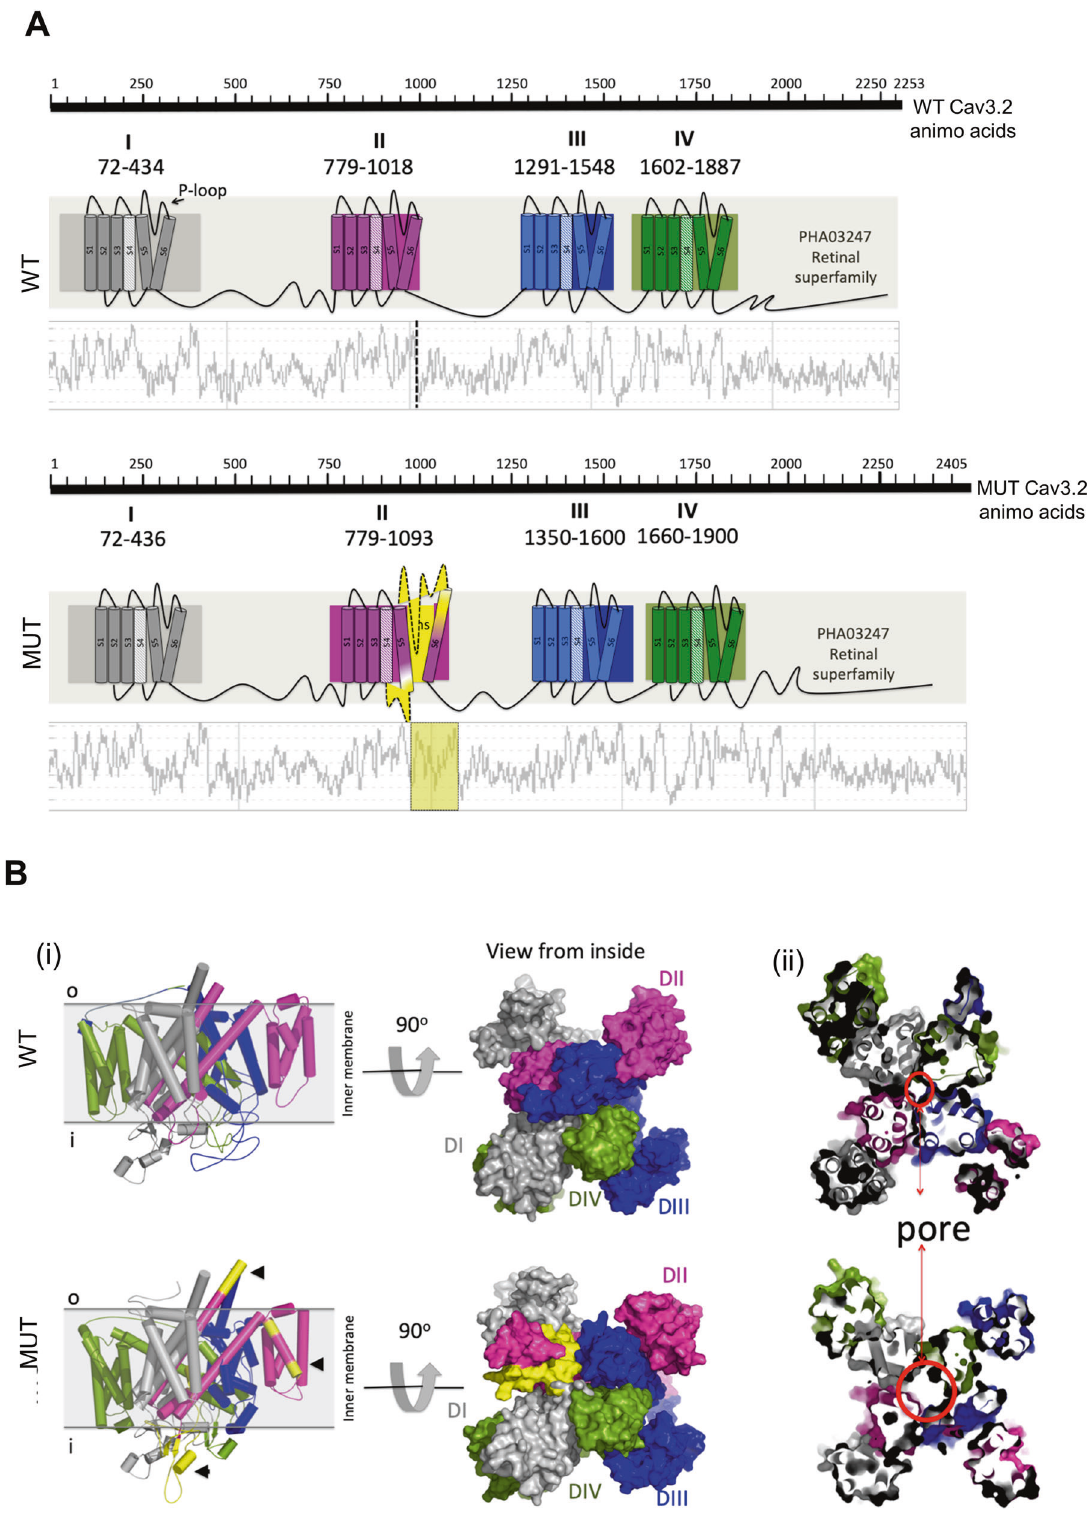
Fig. 2 3D model of the mutant Cav3.2 channel reveals signi fi cant structural changes. A Predicted topologies of the wild type (WT) and mutant (MUT) Cav3.2 channels showing the four homologous domains (I – IV) in different colors, each composed of six transmembrane segments (bars S1 – S6). The 52-amino acid insertion (yellow) is located between segments S5 and S6 of domain II (between residues Q 969 and I 970 ). The hydropathy pro fi les of the amino acid sequences are shown below the channel topologies. B Structural features of the WT and MUT Cav3.2 channels. Bi Simulations of the proteins viewed from the cytosolic side of the plasma membrane are shown in cartoon representation and colored by domain (DI – DIV). Domain II is colored in magenta and the 52-amino acid insertion is detached in yellow. Bii Structural view of the pore center showing the differences in the pore diameter between WT and MUT Cav3.2